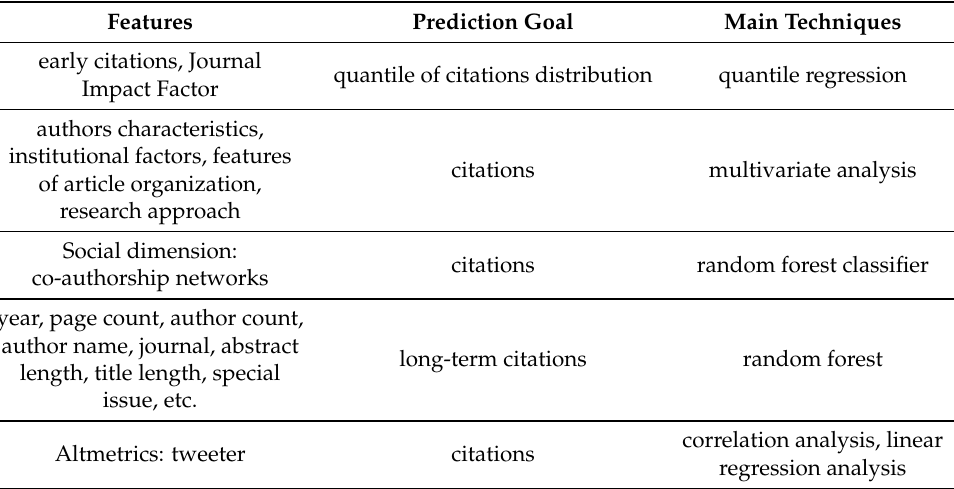
Figure 5. Flowchart of predicting article impact. Table 1. Several representative methods for predicting article